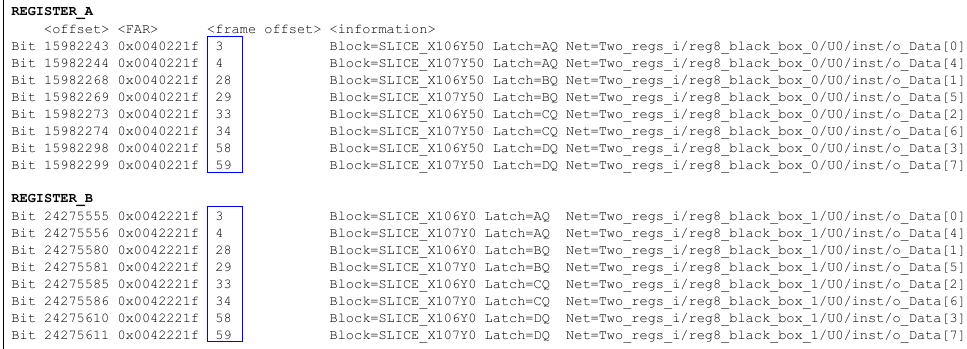
Figure 9. Fragment of the .ll file from the design with placement